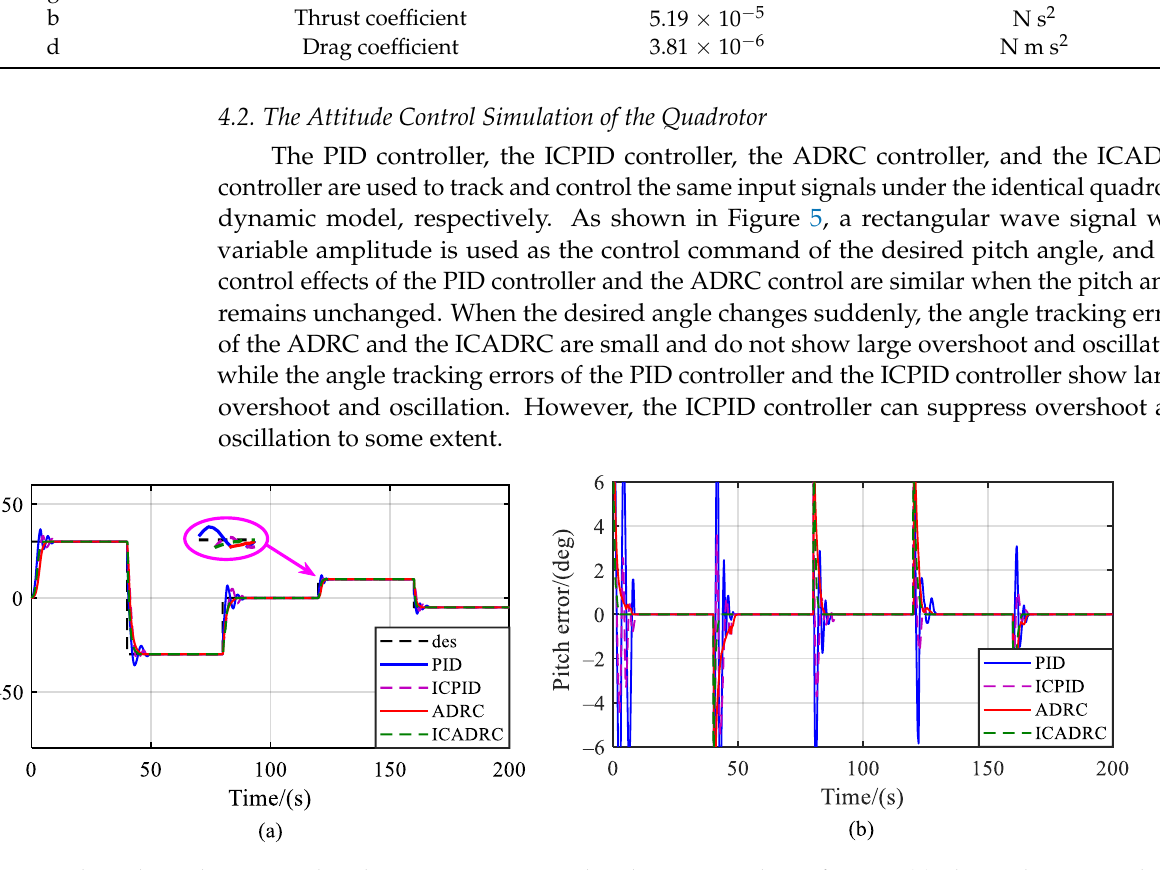
Figure 6. Pitch angle tracking control under sinusoidal signal without external interference. ( a ) The tracking control effects of several controllers under the same sinusoidal signal; and ( b ) tracking er- rors of several controllers.